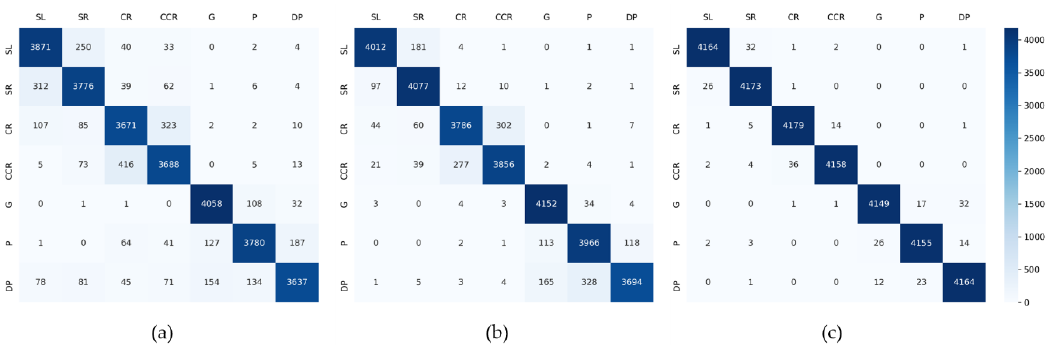
Figure 16. The gesture recognition accuracy of three system for each participant.